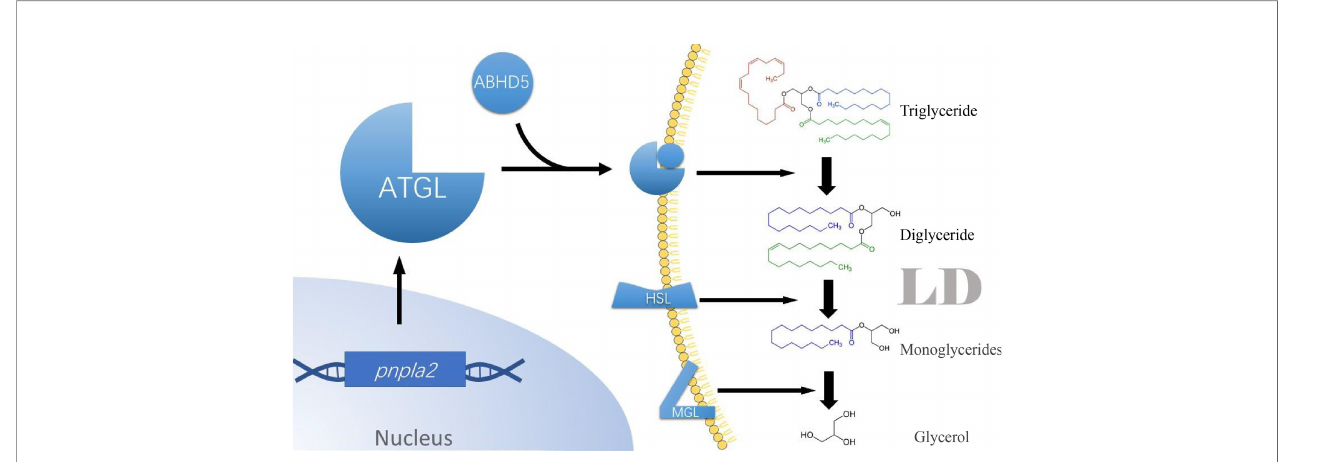
FIGURE 1 | Series hydrolysis process of triglycerides by different lipases sitting in lipid droplets (LOs) membrane. ATGL binds to coactivator ABHDS and co-binds to the LD membrane. ATGL then hydrolyzes triglyceride to diglycerides and releases a molecu le of free fatty acids. HSL then hydrolyzes the diglycerides to glycerol monoesters and releases one molecule of free fatty acids. Finally, MGL hydrolyzes triglycerides and releases the last molecule of free fatty acids. ATGL, Adipose triglyceride lipase; ABHDS, 1-acylglycerol-3-phosphate 0-acyltransferase; HSL, Hormone-sensitive lipase; MGL, Monoacylglycerol